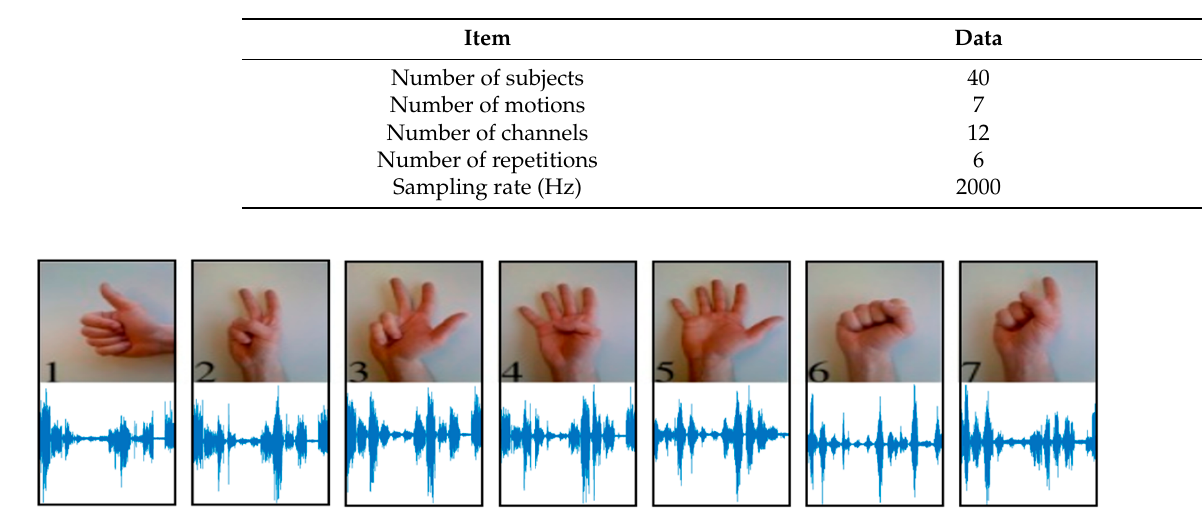
Table 3. sEMG signal database composition.